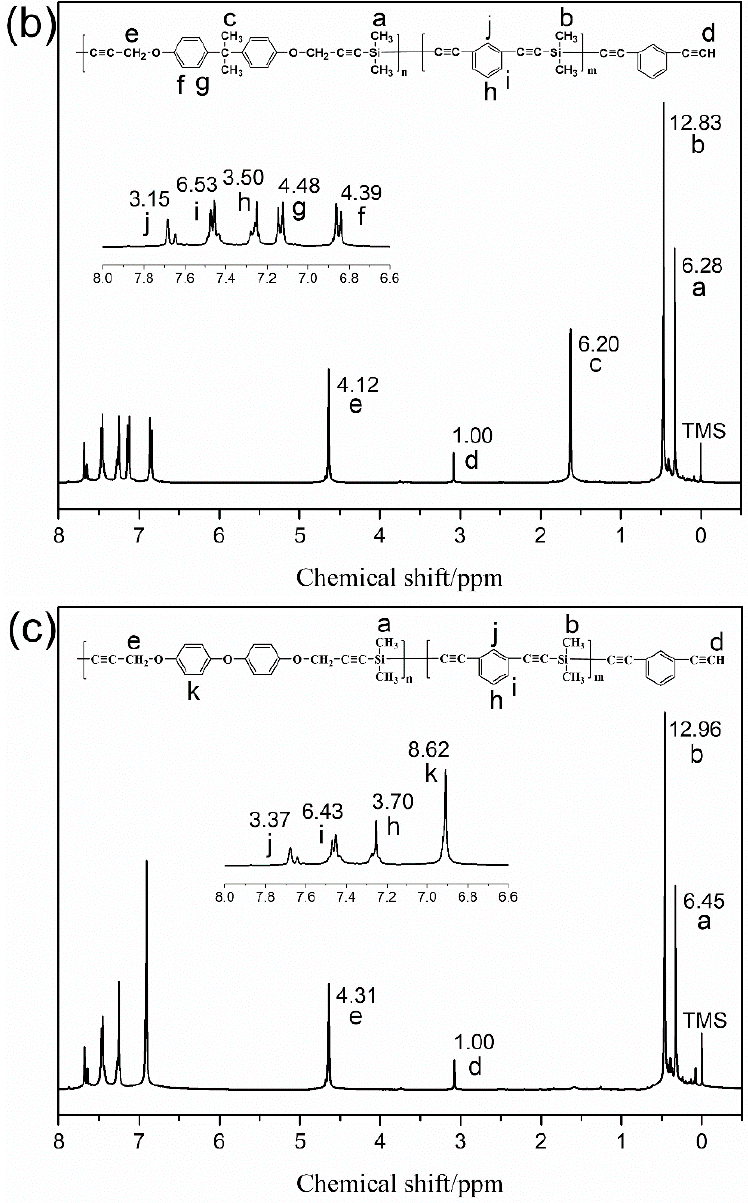
Figure 1. 1 H-NMR spectra of three polymers: ( a ) AAA polymer; ( b ) ABA-A copolymer; ( c ) ABA-O Figure 1. 1 H ‐ NMR spectra of three polymers: ( a ) AAA polymer; ( b ) ABA ‐ A copolymer; ( c ) ABA ‐ O copolymer.